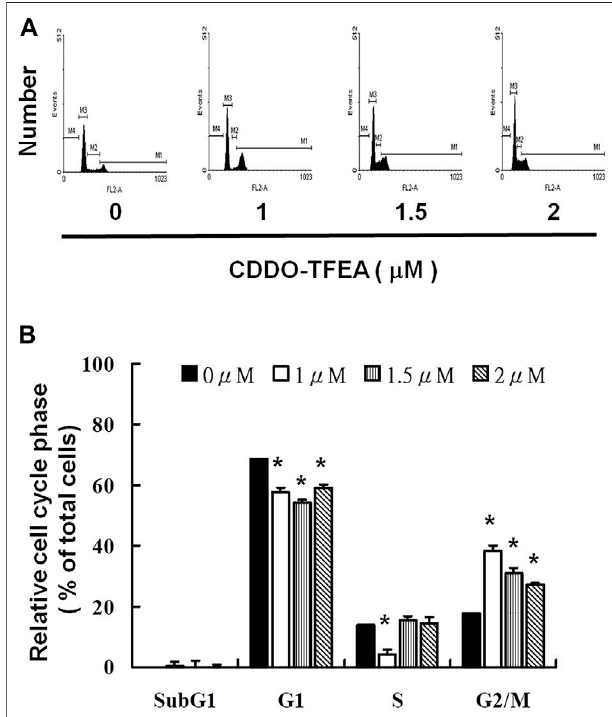
FIGURE 5 | (A) Cell cycle arrest of GBM8401 cells in the G2/M phase caused by CDDO-TFEA treatment. Cell cycle analysis was conducted after 24 h of culture with CDDO-TFEA. CDDO-TFEA induced an increase in the proportion of cells inthe G2/M phase. Propidium Iodide (PI) staining was conducted for DNA content analysis. Quanti fi cation was then performed through fl ow cytometry panel (B) . In each group of bars, * indicates that the number of G2/M cells in the treatment group was signi fi cantly higher than that in the control group ( p <